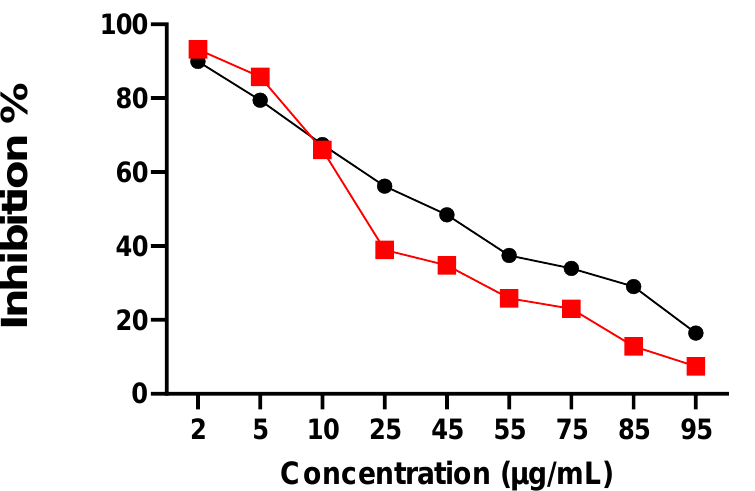
Figure 3. Effect of Taraxacum officinale EO on the growth of HeLa cell line. TO: Taraxacum officinale essential oil; DOX: standard doxorubicin (results are expressed as mean ± SD. ( n = 5). At the highest applied dose (95 µg/mL), a significant ( p < 0.0001) maximum inhibitory effect of TO EO on HeLa cell line growth was recorded (% I: 83.58%; IC 50 = 45.56 ± 0.05 µg/mL) but lower than that recorded by the standard DOX (% I = 92.50%; IC 50 = 4.34 ± 0.02 µg/mL) (Figure 3). At lower doses (2 – 10 µg/mL), the oil was still toxic to HeLa cells with comparable inhibition to DOX.